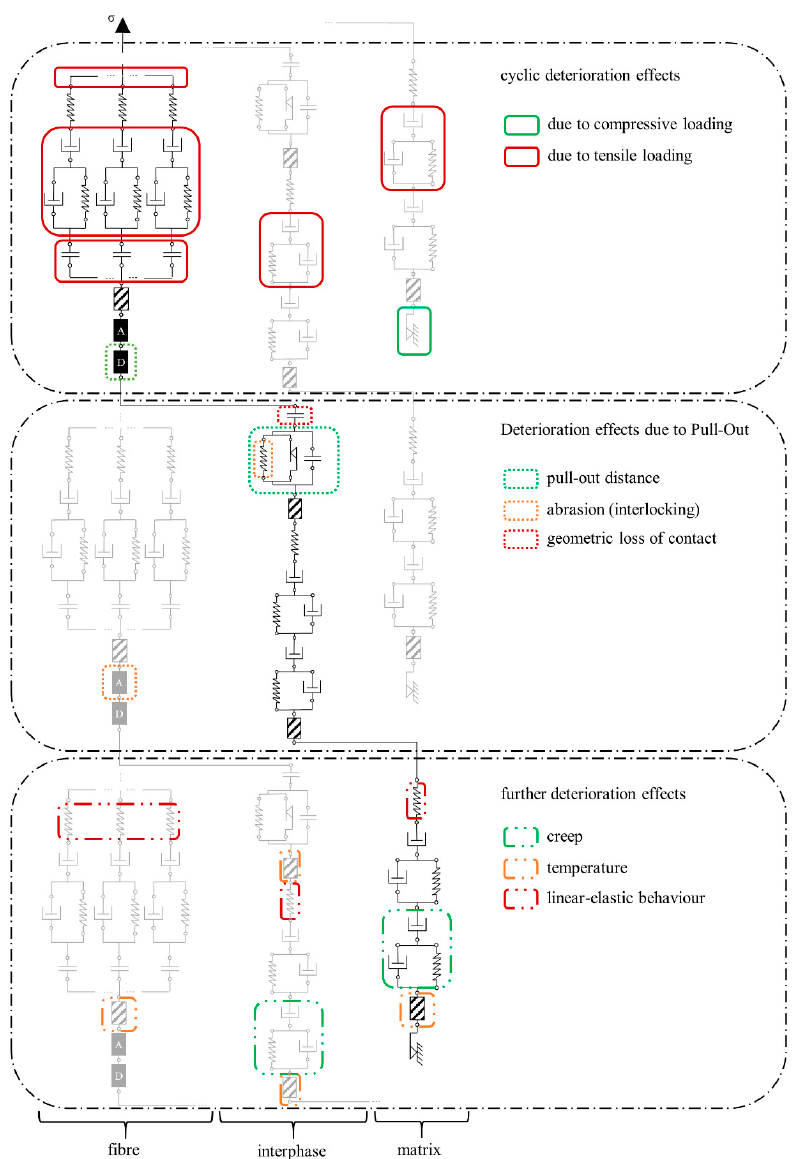
Figure 18. Complete rheological model with highlighted effects on the strain, one load path is highlighted in black, the incomplete displayed load paths are light grey. Each element group occurs several times (three times are displayed here).